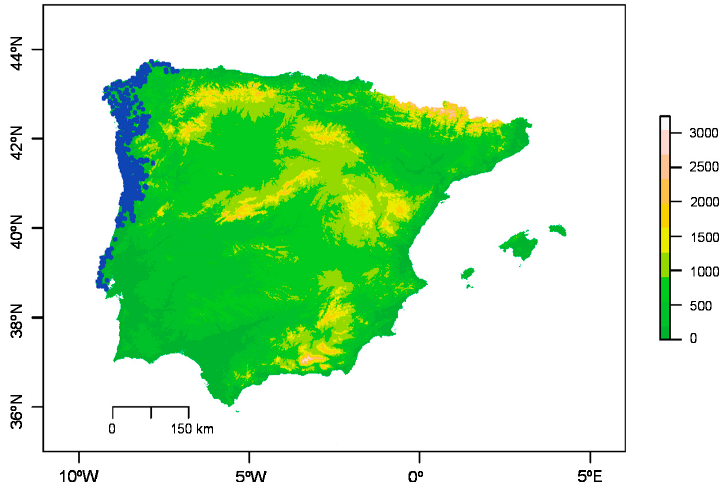
Figure 1. Occurrence-based distribution map of Trioza erytreae (del Guercio) throughout the Iberian Peninsula. Blue dots represent occurrence records projected on a digital elevation model. Altitude is expressed in meters (m). Results are shown for mainland Portugal and Spain and Balearic islands.